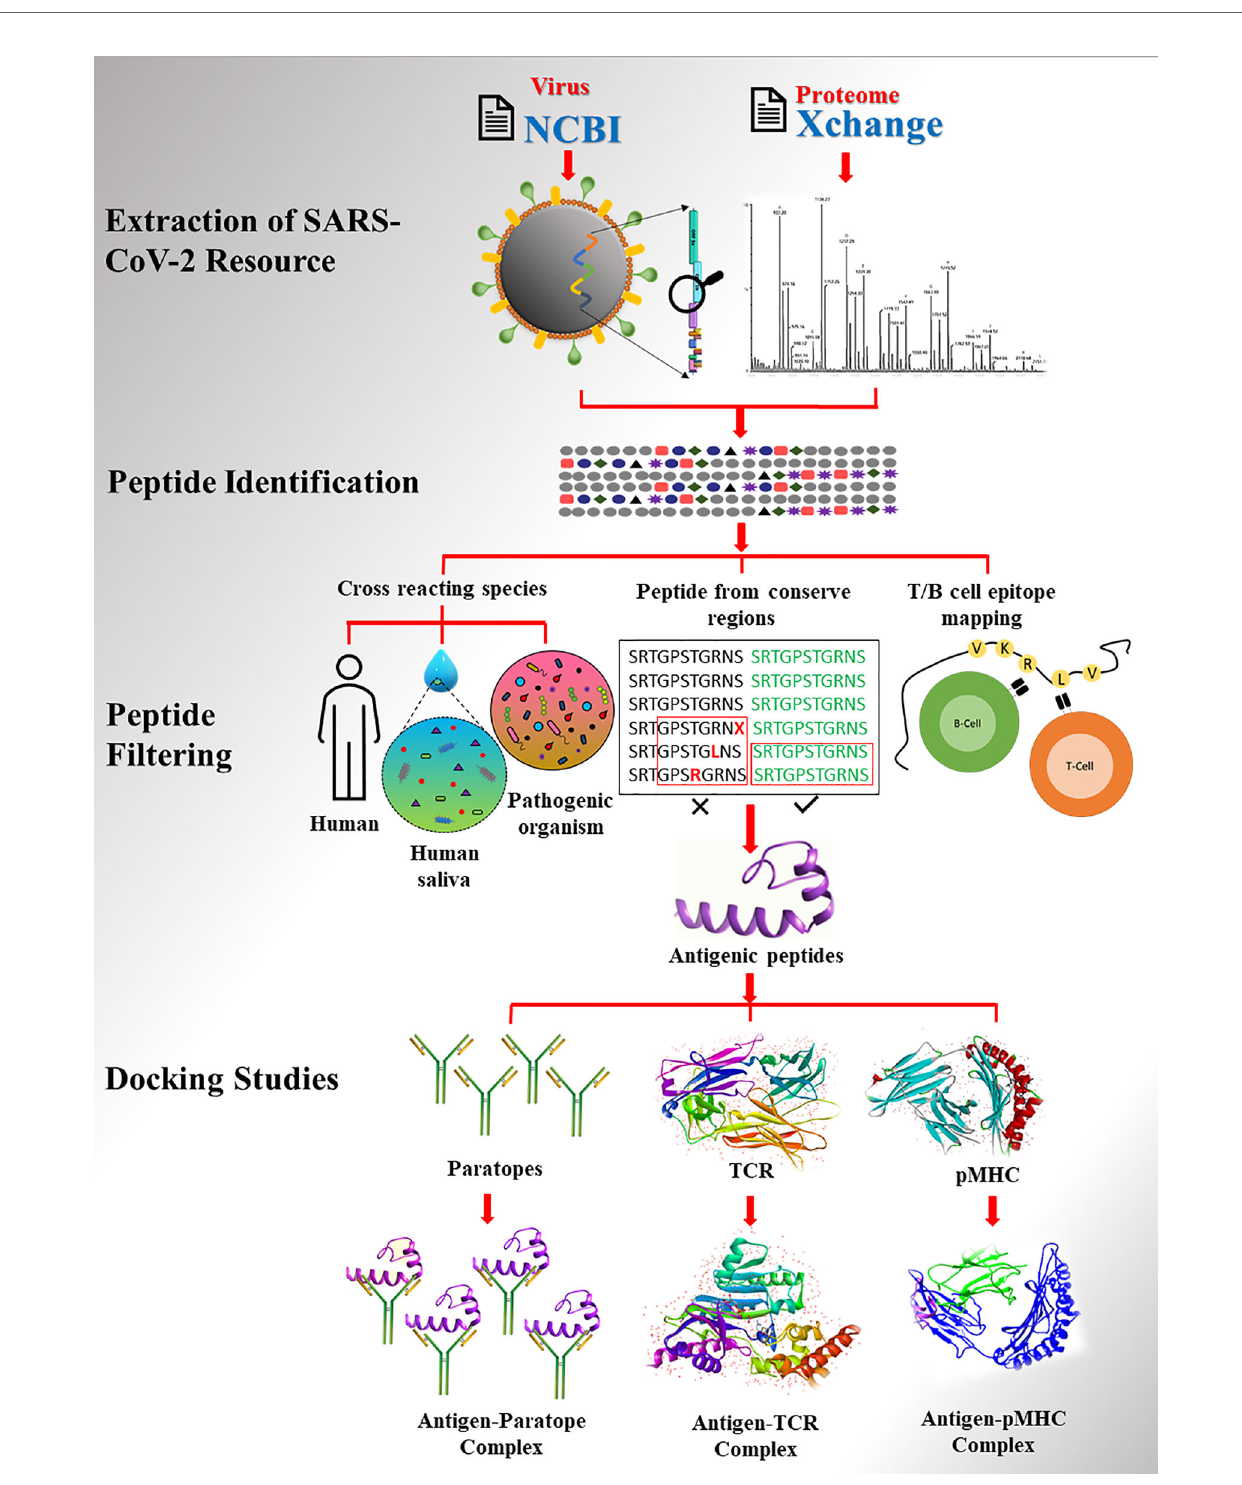
FIGURE 1 | The work fl ow of study. SARS-CoV2 proteome extracted from database followed by peptide identi fi cation and fi